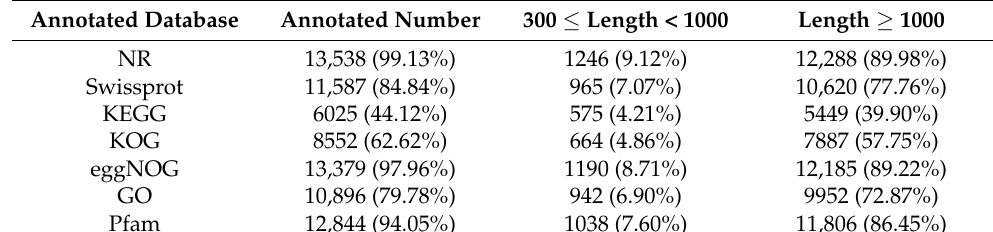
Table 2. Summary of function annotation of cannabis full-length transcriptome.